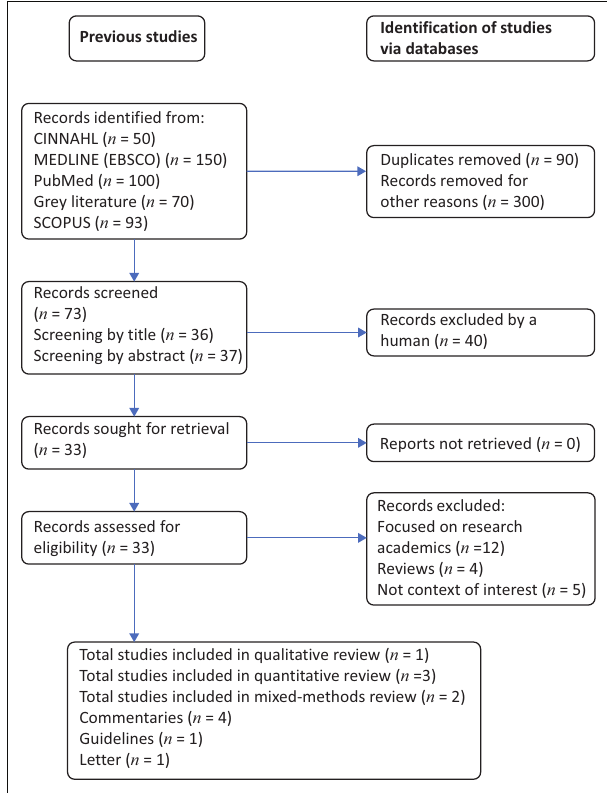
FIGURE 1: PRISMA 2020 flow diagram of studies included in the review.